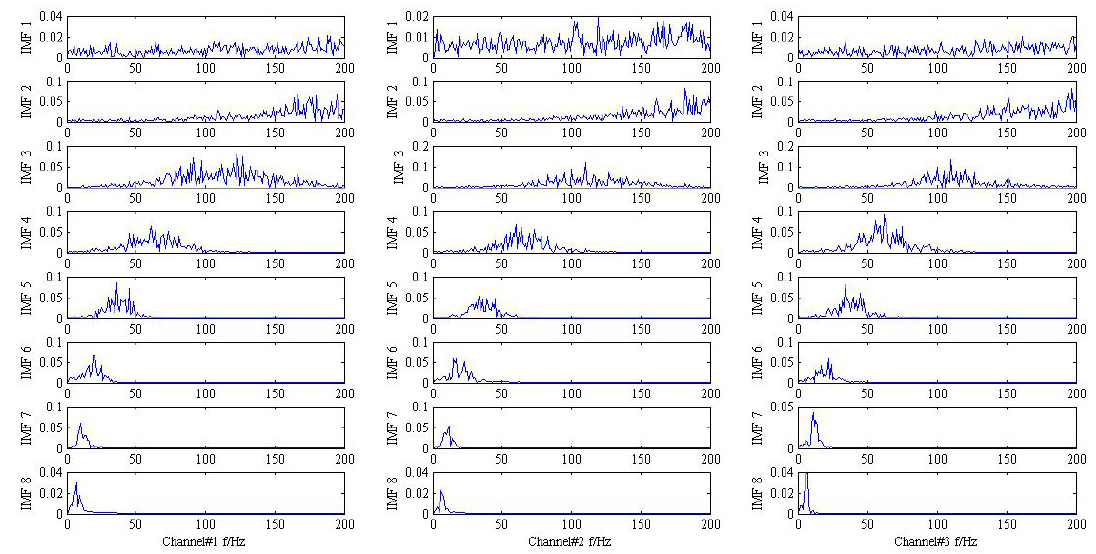
Figure 3. The result provided by the MEMD method.